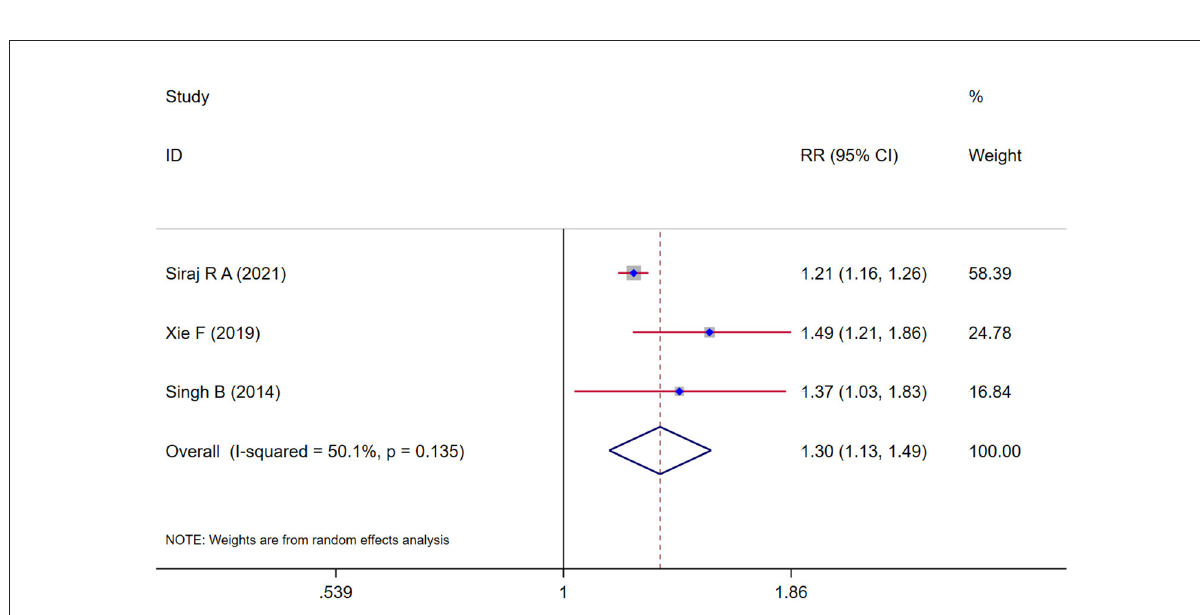
FIGURE5 Forest plot showing the effect of COPD on cognitive impairment.